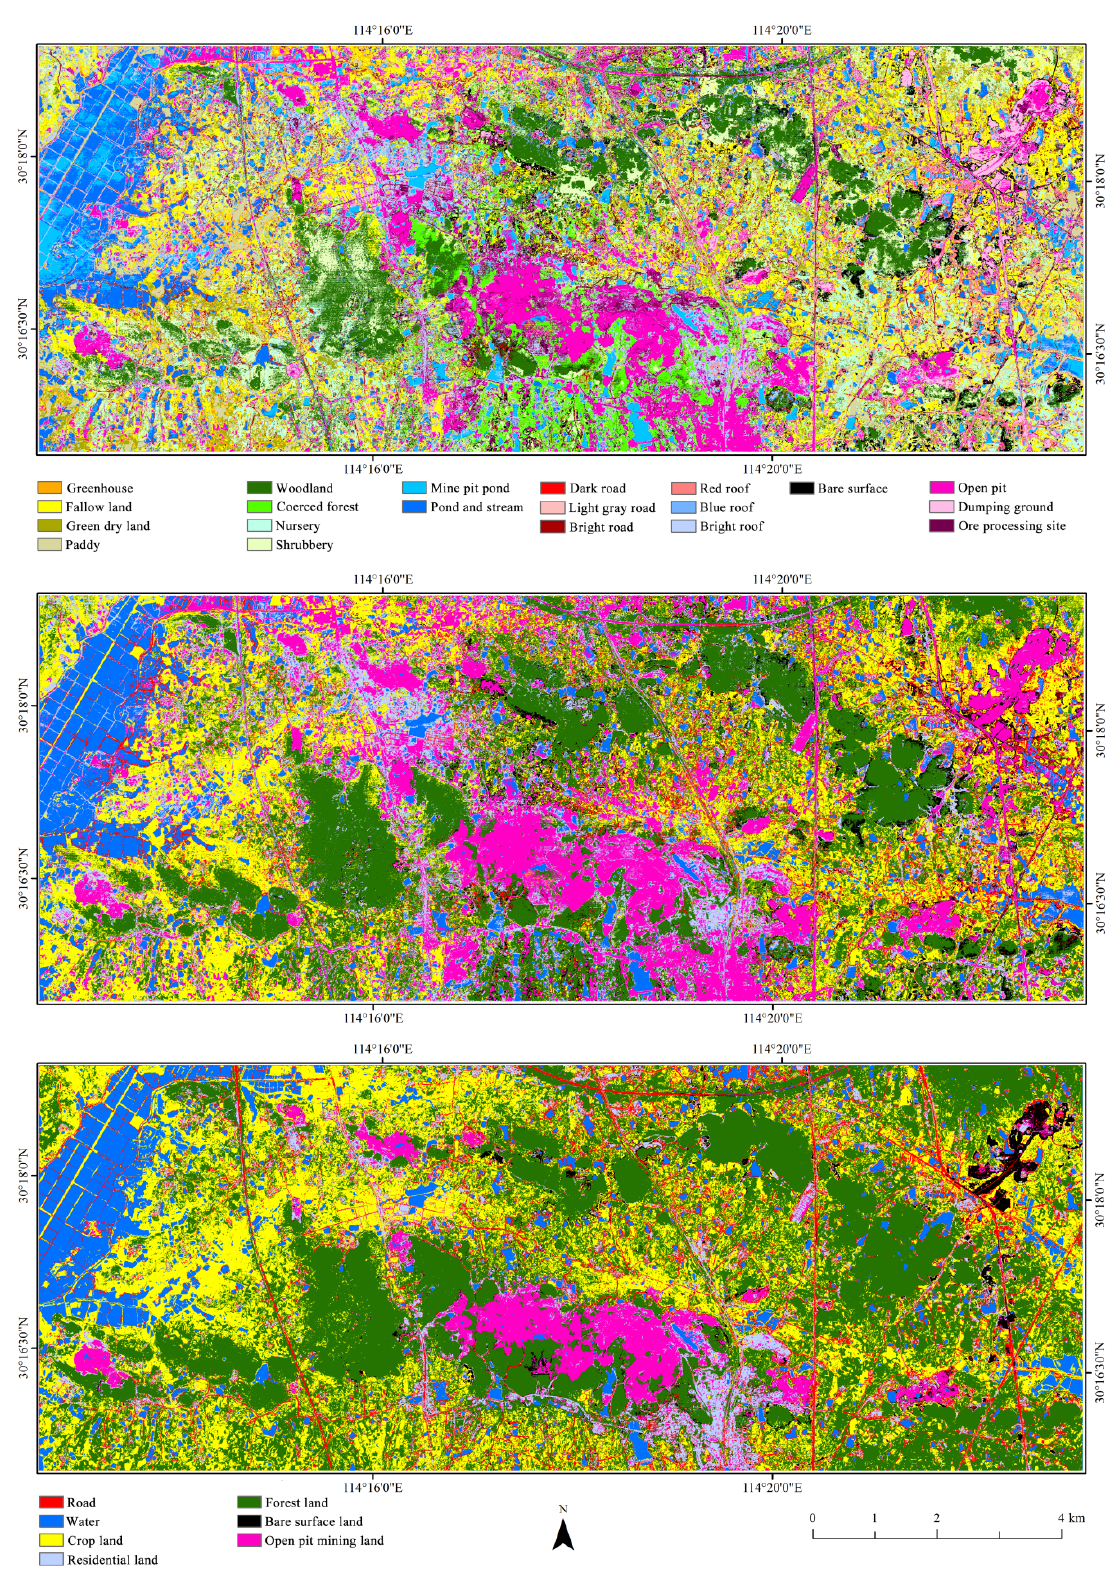
Figure 10. The predicted maps of fine land cover classification (LCC) based on the fused model of deep belief network and support vector machine (DBN-SVM), and LCC based on DBN-SVM and random forest with feature seleciton method [12] (from top to